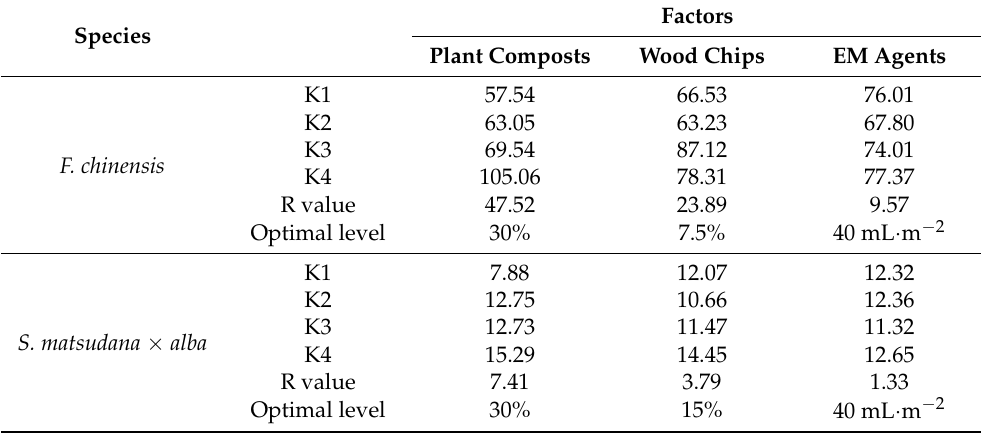
Table 6. Range analysis of Cu extraction of above-ground parts of two woody species. Species